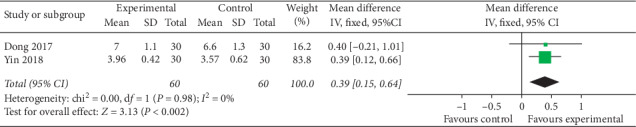
Forest plot of experimental groups versus control groups: Schober test outcome.